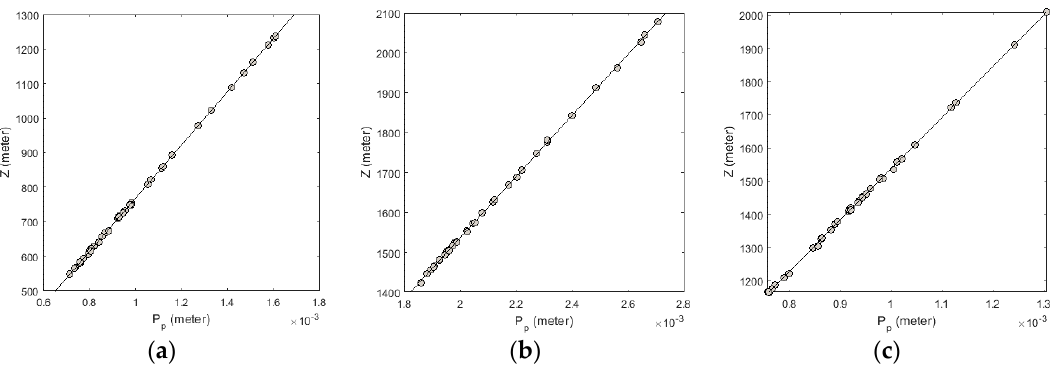
Figure 10. The scatter plot of the horizontal parallax of ChCP and their heights in Experiments 2, 6, and 10: ( a ) Isfahan dataset; ( b ) Zanjan dataset; ( c ) Fars dataset.